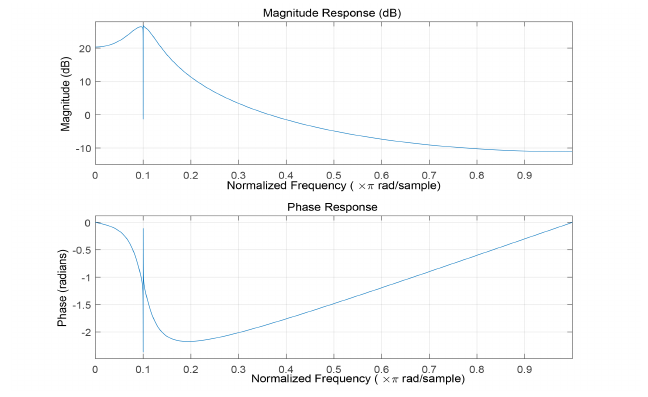
Figure 2. The MPPSK Waveforms.